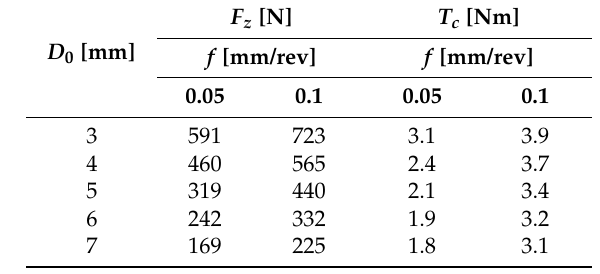
Table 4. Experimental results for F z [N] and T c [Nm] in Ti-6Al-4V alloy.